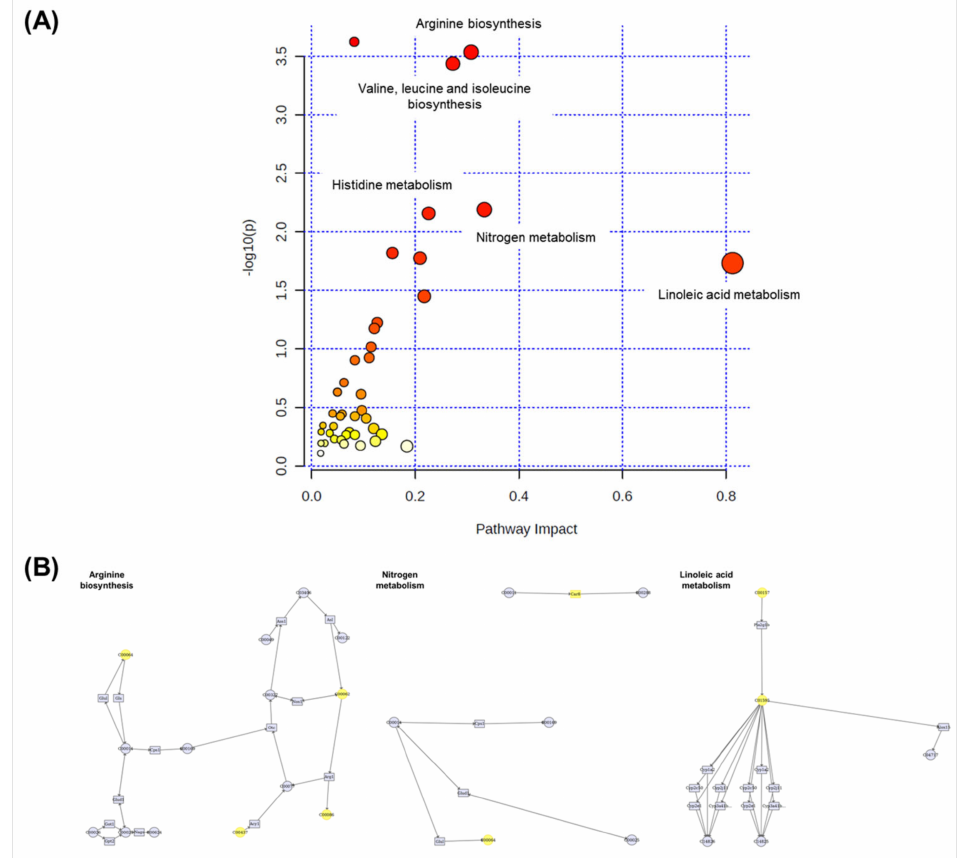
Figure 11. The pathway impact analysis. ( A ) The metabolic pathways were represented as circles according to their scores from enrichment (y-axis) and topology analyses (pathway impact and x-axis) using MetaboAnalyst 5.0. Darker circle colors indicated more significant changes in metabolites in the corresponding pathway. The size of the circle corresponds to the pathway impact score and was correlated with the centrality of the involved metabolites. ( B ) Three most representative pathways from metabolic pathway changes. The yellow circle represents the affected part of the detailed